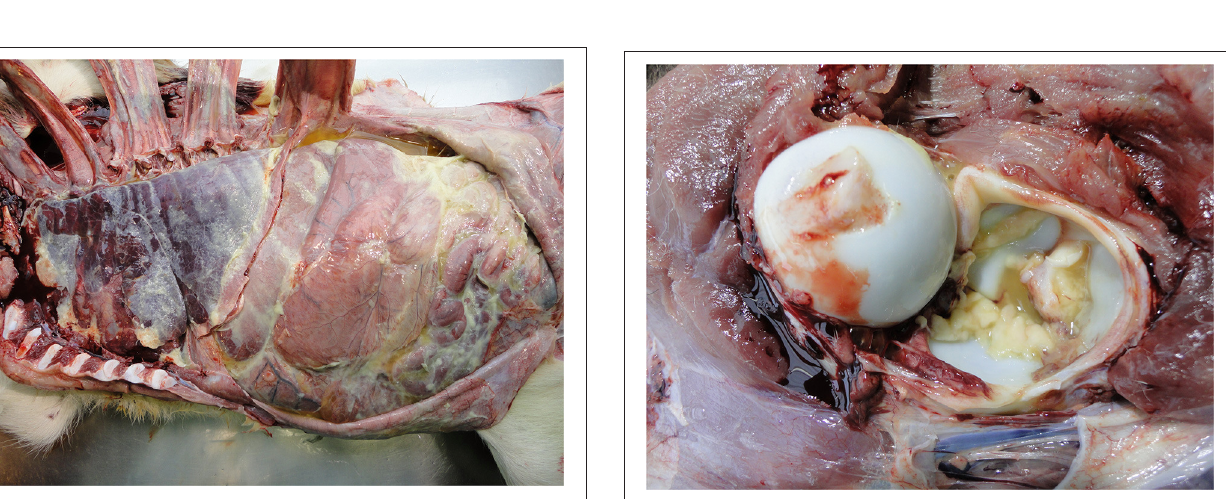
FIGURE 13 | Sepsis affecting the thorax and abdomen of a calf.